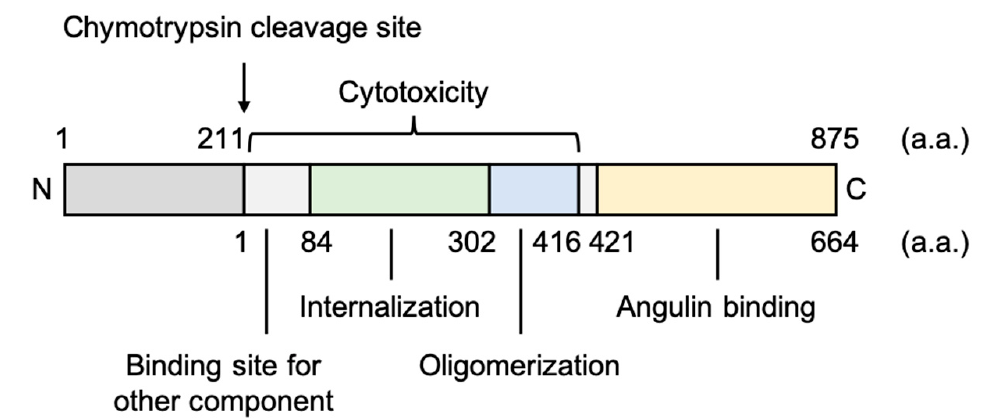
Figure 5. Structure of Clostridium perfringens iota-toxin component Ib [102]. The GenBank protein accession number is WP_003463384.